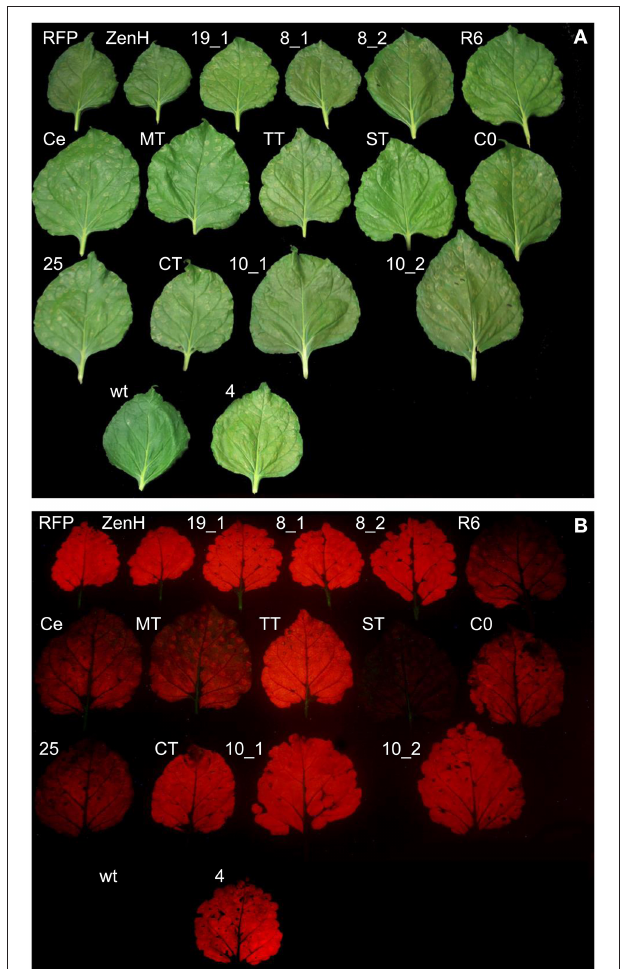
FIGURE 2 | Visualization of RFP accumulation in infiltrated N. benthamiana leaves. Accumulation of RFP-antigen fusion proteins can be visualized under green light using a red filter ( Rademacher et al., 2008). Non-infiltrated (wt) and infiltrated N. benthamiana leaves infiltrated with different RFP-fusion constructs under white light (A) and under green light (B)